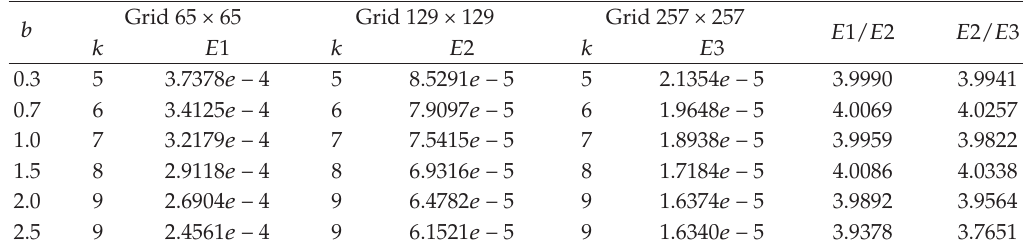
Table 2: Convergence of the method in Example 4.3 for a (cid:10) 0 . 5.